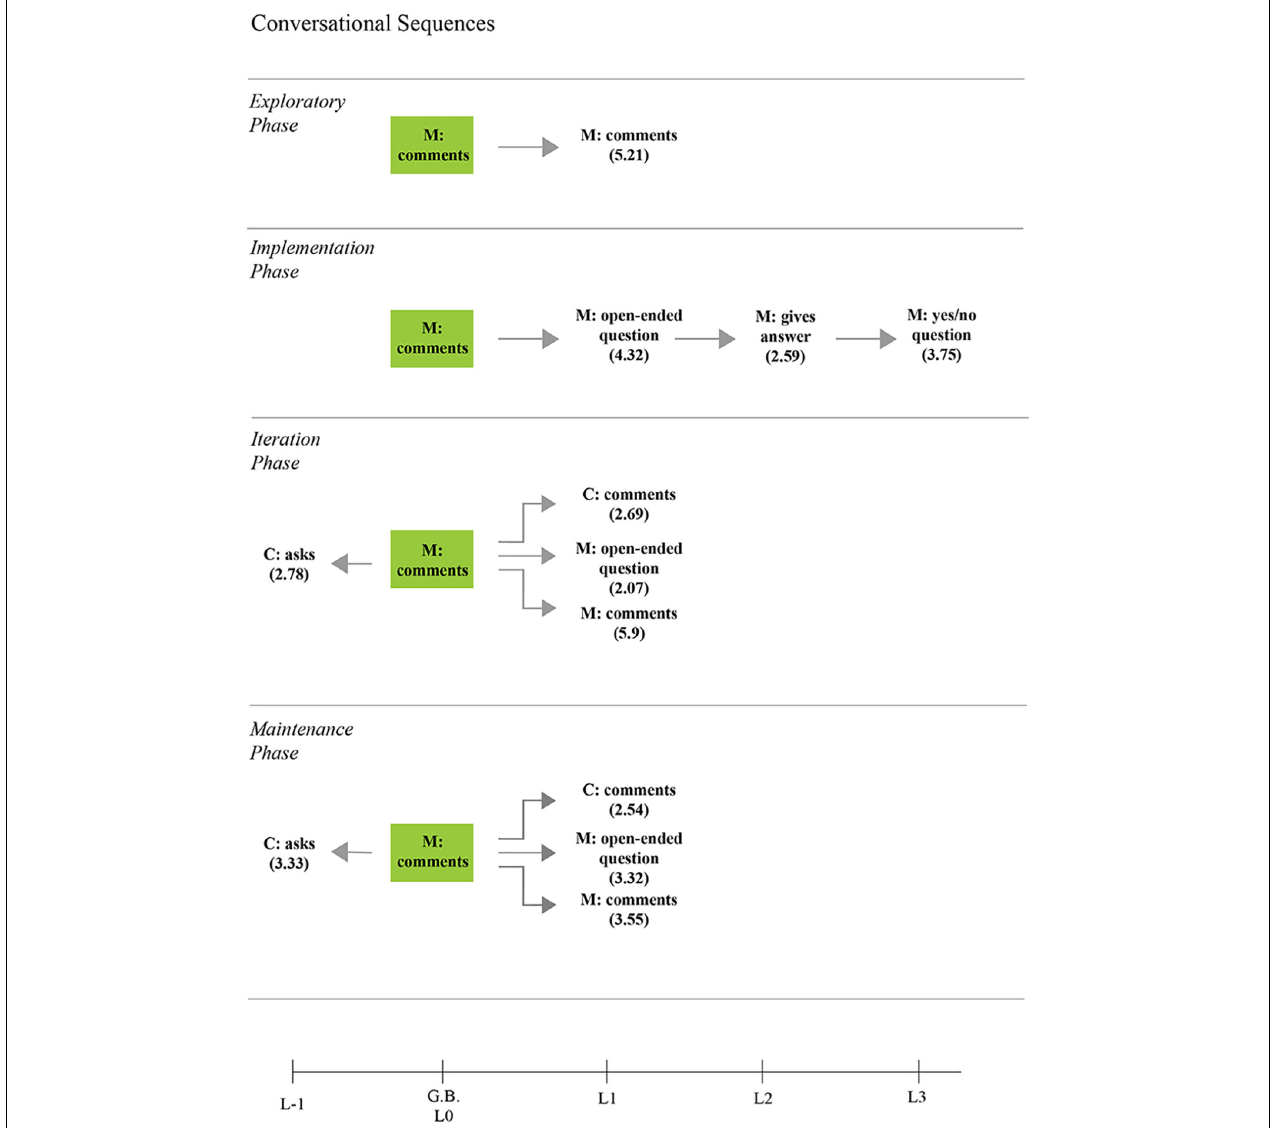
FIGURE 8 | Sequential communicative patterns between mother–child during storybook reading with the mother’s emotion-related comments as given behavior [M, Mother; C, Child].